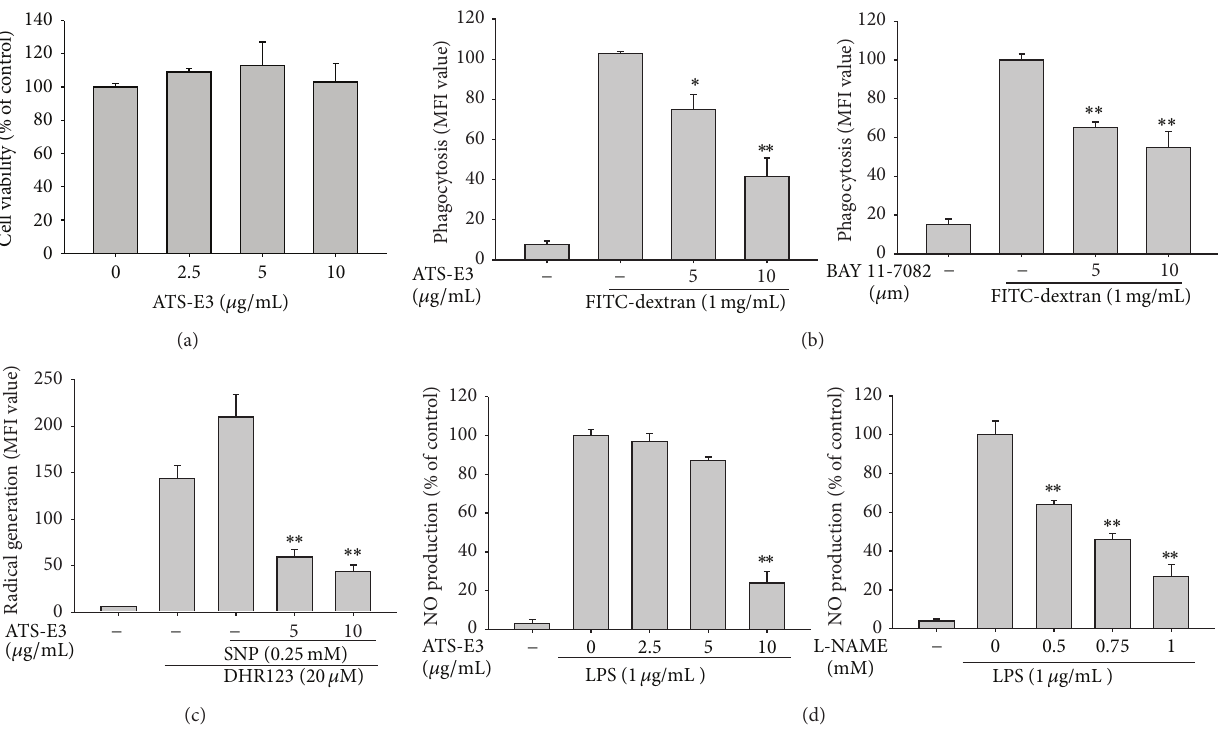
Figure 2: The effects of ATS-E3 on macrophage-mediated inflammatory responses. (a) RAW264.7 cells (1 × 10 6 cells/mL) were treated with ATS-E3 for 6 or 24 h. Cell viability was evaluated using the MTT assay. (b) RAW264.7 cells preincubated with ATS-E3 (left panel) or BAY11- 7082 (right panel) were treated with FITC-dextran (1mg/mL) for 2 h. The level of dextran uptake was determined by flow cytometric analysis. (c) Scavenging effect of ATS-E3 on reactive oxygen species (ROS) generation in sodium nitroprusside- (SNP-) treated RAW264.7 cells was examined by flow cytometric analysis using DHR123 (20 𝜇 M) and SNP (0.25 mM). (d) NO inhibitory activities of ATS-E3 (left panel) or L- NAME (right panel) were determined with RAW264.7 cells (1 × 10 6 cells/mL) treated with LPS (1 𝜇 g/mL) in the presence or absence of ATS-E3 or L-NAME for 24 h. The cell culture supernatants were collected, and the concentrations of NO in the supernatants were determined using the Griess assay. ∗ 𝑃 < 0.05 and ∗∗ 𝑃 < 0.01 compared to control